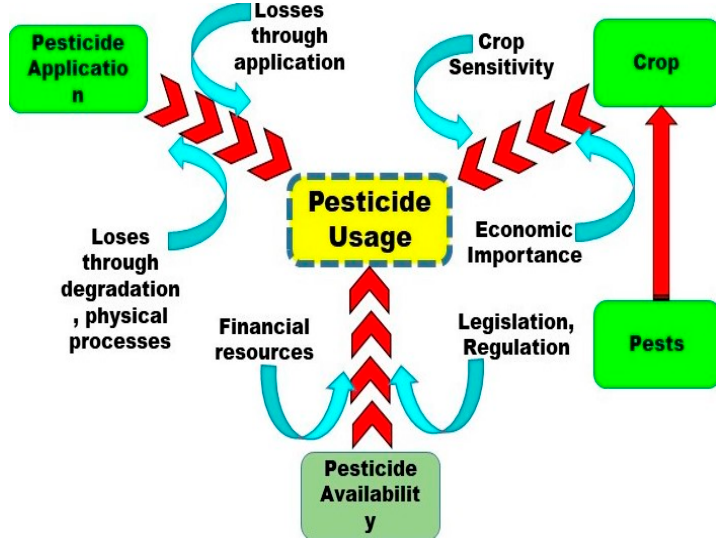
Int. J. Environ. Res. Public Health 2020 , 17 , x Figure 3. Influencing factors for pesticide use (by authors). Figure 3. Influencing factors for pesticide use (by authors).